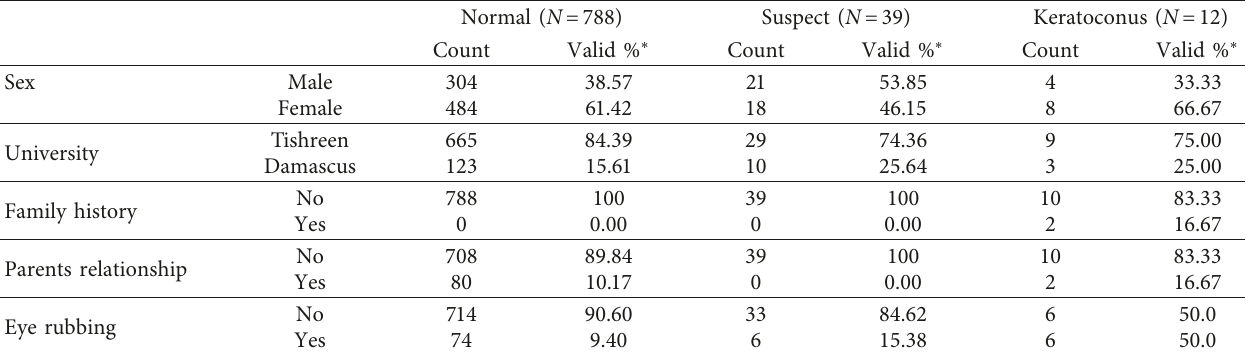
Table 3: Summary statistics of the outcome (patient outcome) and categorical explanatory